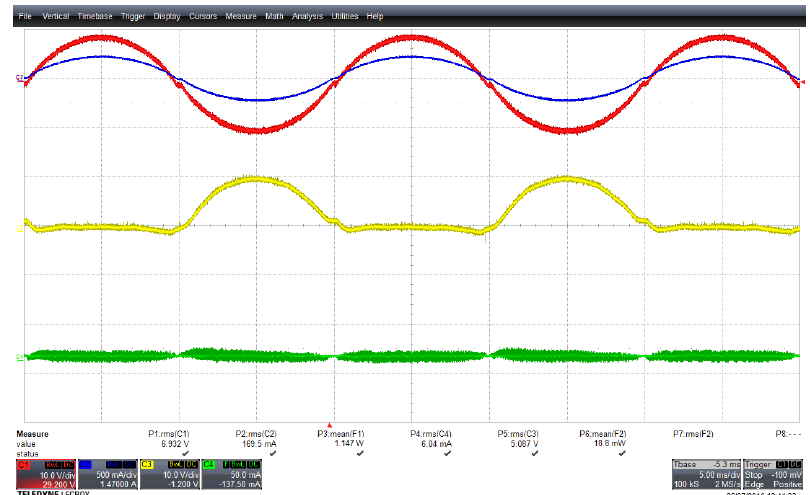
Figure 19. Experimental results of proposed CSI5 solution. Trace list from top to bottom: output voltage (red trace, 10 V/div), output current (blue trace, 500 mA/div), ground voltage (yellow trace, 10 V/div), and ground leakage current (green trace, 50 mA/div). c (cid:13) 2016 IEEE